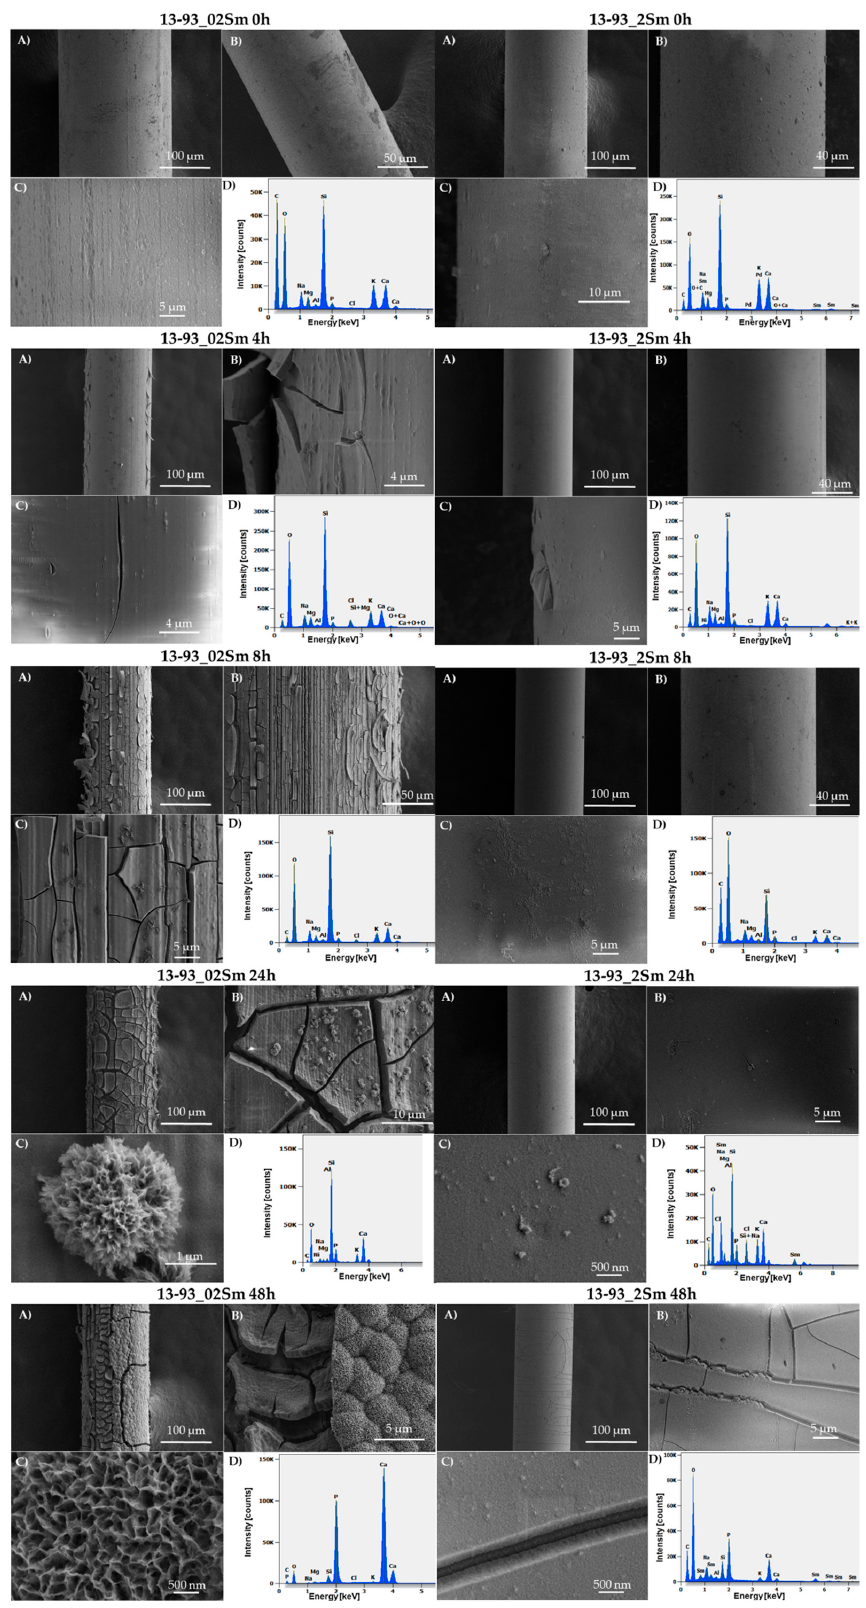
Figure 7. SEM micrographs of 13-93_02Sm and 13-93_2Sm bioactive glass fibers immersed in SBF for 0, 4, 8, 24, and 48 h, with EDS spectra of the surfaces. ( A – D ) are there to distinguish the scale in the images, and to clarify the description of a specific